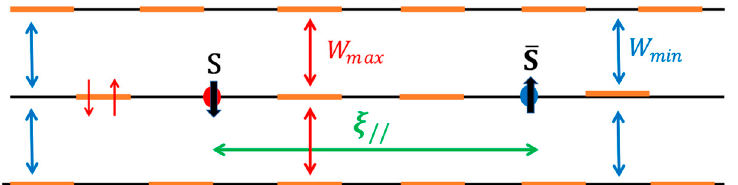
Figure 12. Schematic representation of a pair of a spin 1/2 soliton (S) and spin+1/2 anti-soliton (S) shifting the phase of the SP intra-chain dimerization on ξ // . In addition, between the S and S entities the phase shift between neighboring dimers changes from π to 0. This enhances the inter-dimer coupling energy from W min to W max , as schematically indicated.